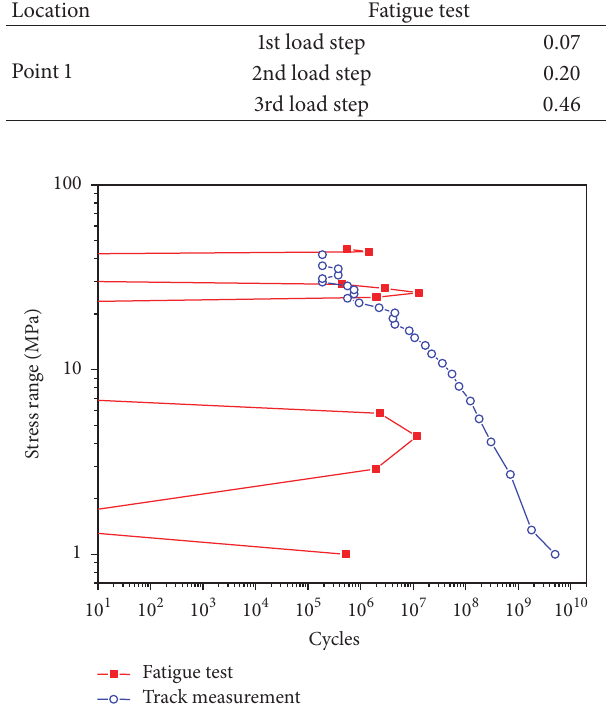
Figure 17: Comparison of cycle counting results in fatigue test and track test (Point 1).